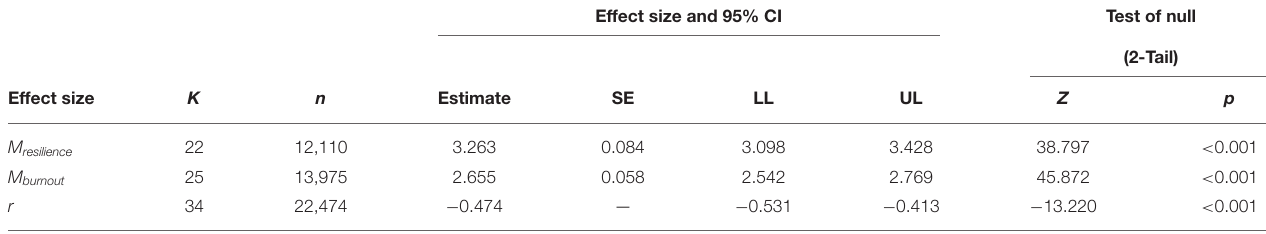
TABLE 3 | The summary effect size calculation.